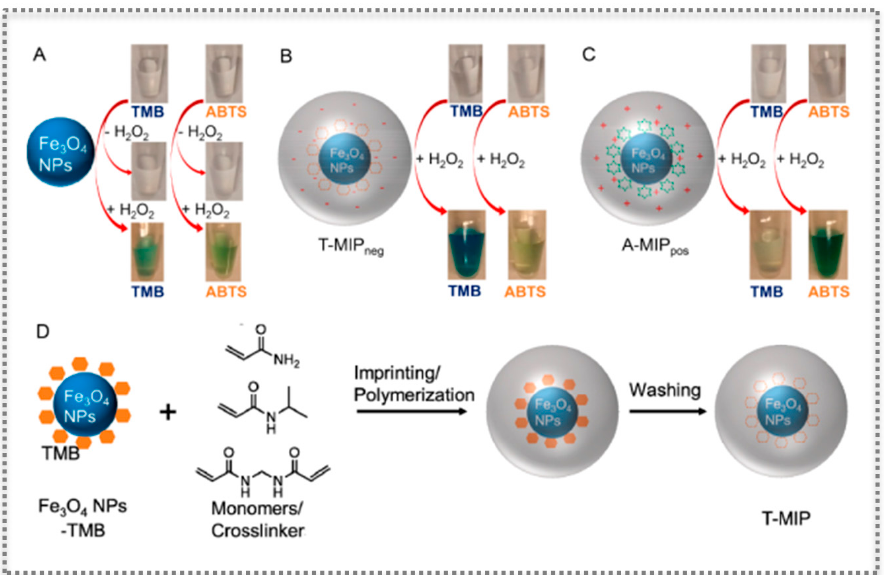
Figure 9. Molecular imprinting on nanozymes: Photographs and schemes showing bare Fe 3 O 4 nanozyme ( A ), with an anionic MIP layer (T-MIP neg ) ( B ) and with a cationic MIP layer (A-MIP pos ) ( C ) for oxidizing two substrates (TMB and ABTS), as well as scheme of imprinting the nanogel ( D ). (Reproduced with permission [82], Copyright 2017, American Chemical Society).